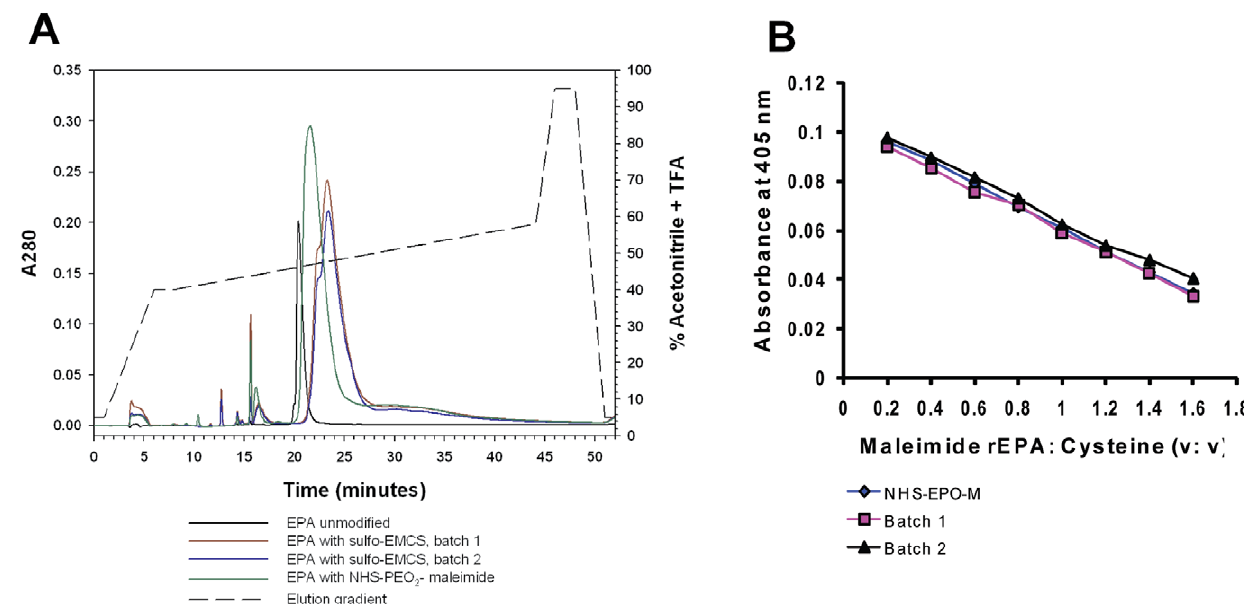
Figure 3. Characterization of chemically modified EPA. Analysis of un-modified EPA, EPA APA batch 1, EPA APA batch 2 and EPA PEO by RP-HPLC (A), and titration analysis of EPA APA batch 1, EPA APA batch 2 and EPA PEO (B) are shown.